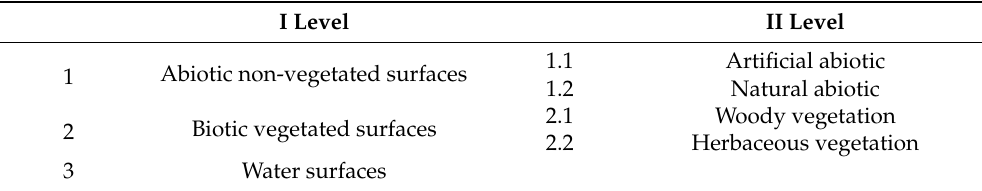
Table 2. EAGLE-compliant classification system adopted for land cover mapping